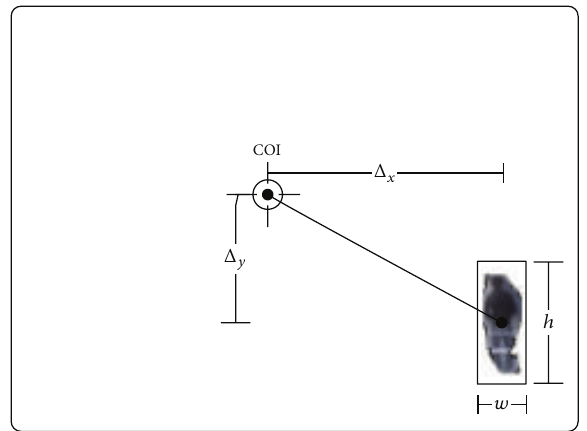
Figure 6: The principle diagram of the acquisition of feedback signal.